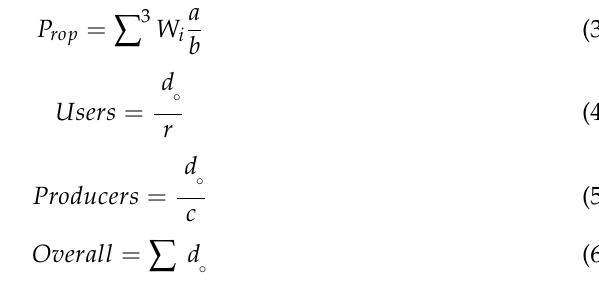
Table 2. Allocation of sample sites to strata for validation data. Class W i U i